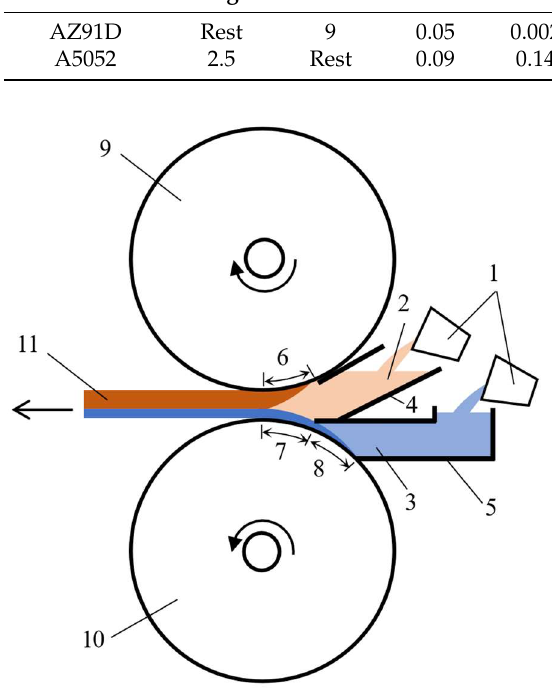
Figure 1. Schematic showing the cladding processes of Mg/Al using a horizontal twin-roll caster (1.